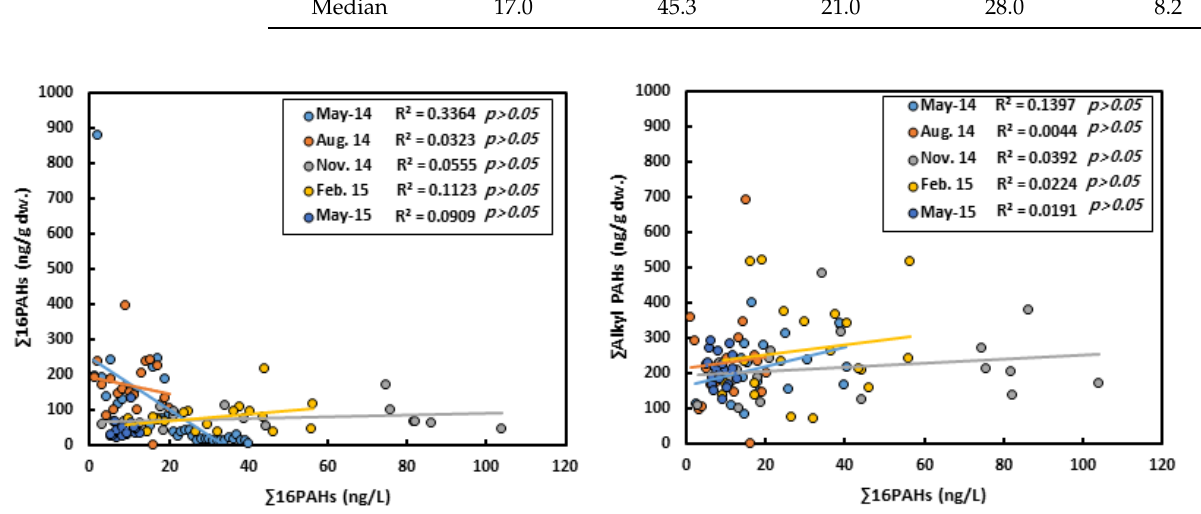
Figure 3. Correlation between 16 water PAHs, 16 sediment PAHs, and alkyl PAHs.